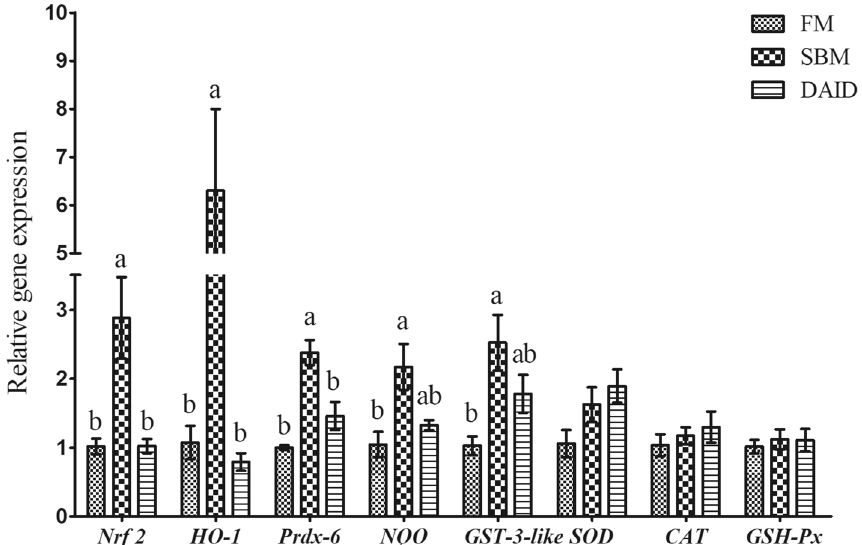
Figure 2. Effects of daidzein on gene expression related to oxidative stress of turbot fed with soybean meal. FM fish meal diet, SBM soybean meal diet, DAID 40 mg/kg daidzein included into SBM diet, Nrf2 nuclear factor E2-related factor 2, HO-1 heme oxygenase-1, Prdx-6 Peroxiredoxin-6, NQO NAD(P)H quinone oxidoreductase, GST-3-like glutathione- S -transferase-3-like, SOD superoxide dismutase, CAT catalase, GSH-Px glutathione peroxidase. Values are mean ± SEM, n = 3 and values shared different letters are significantly different ( P < 0.05).